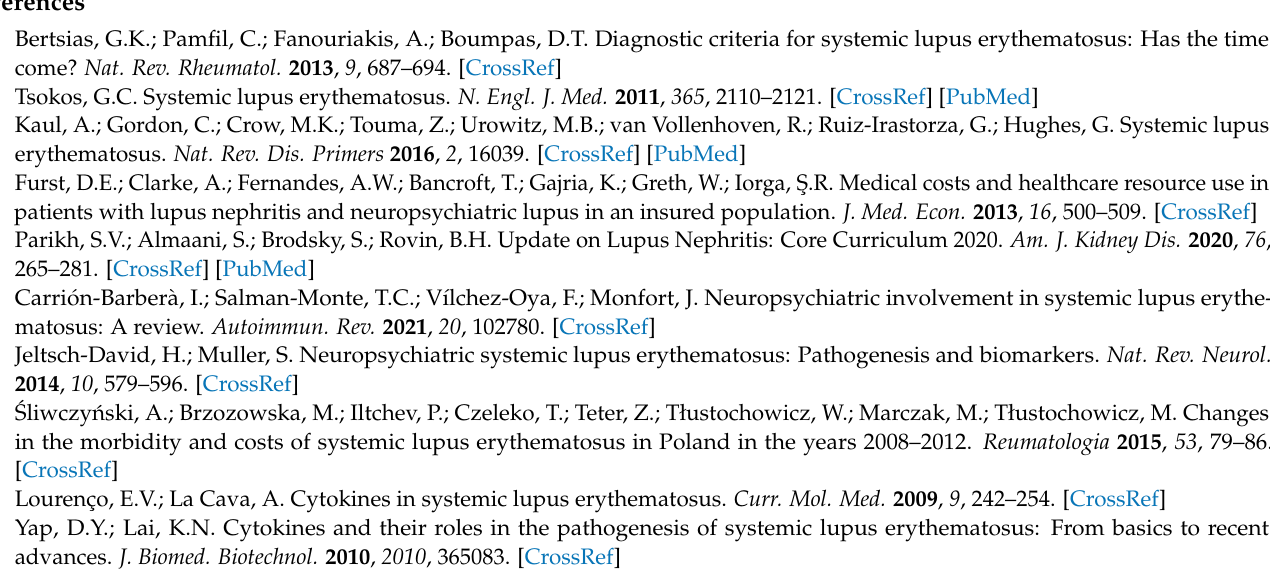
Figure S2: Association between corticosteroid dose and IL-23 and IL-27 levels. Corticosteroid